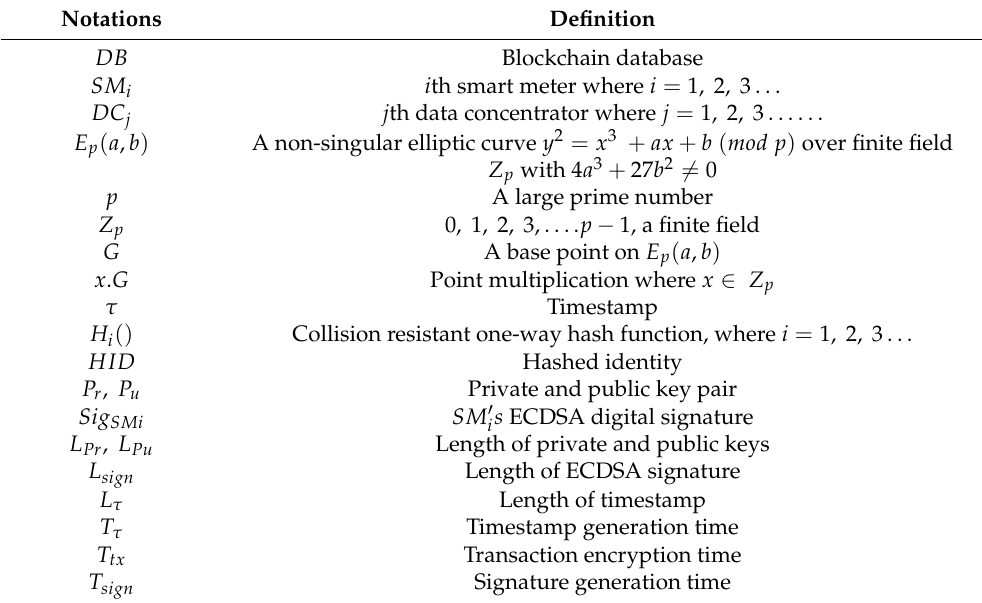
Figure 4. Proposed system model architecture designed with a set of smart meters, smart contract (aka chain code) integrated Hyperledger Fabric blockchain, and MDMS. Table 1. Index of notations used in this paper and their